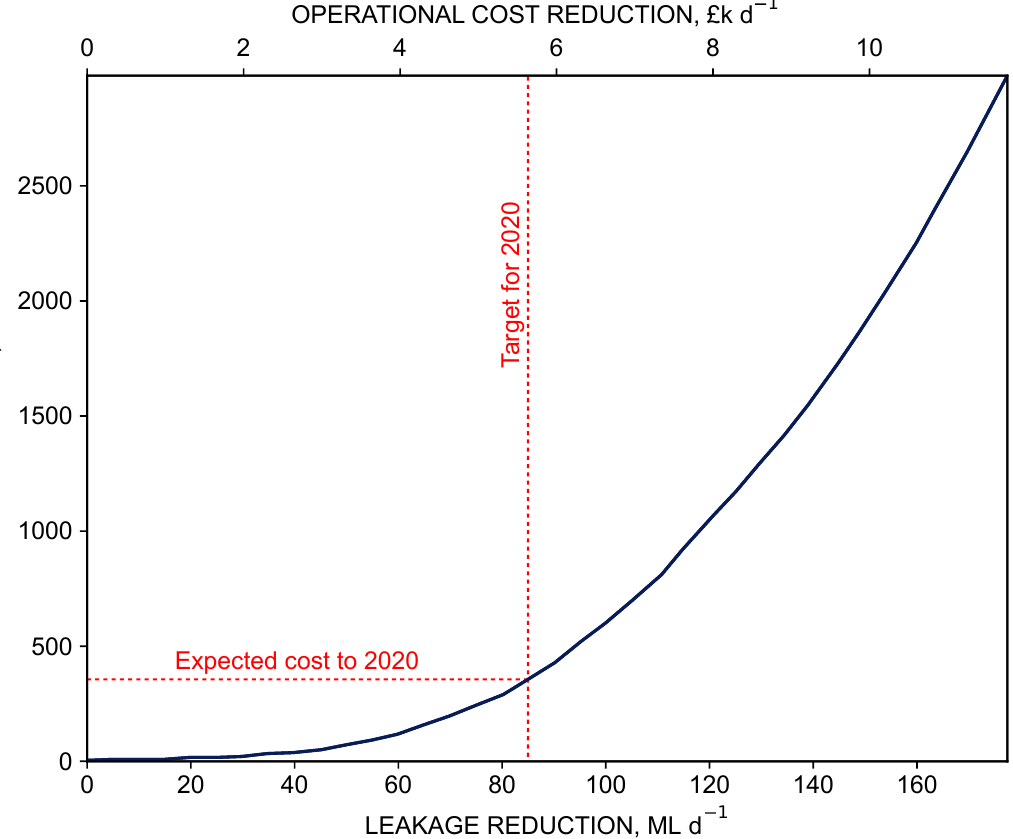
Figure 6. Curve expressing the relationship among capital cost (£ millions), leakage reductions (ML day − 1 ) and reductions in operational expenditures due to electricity consumption (£1000s day − 1 ) for the Thames Water Utilities Ltd. system. The dashed red lines show the company’s leakage reduction targets to 2020